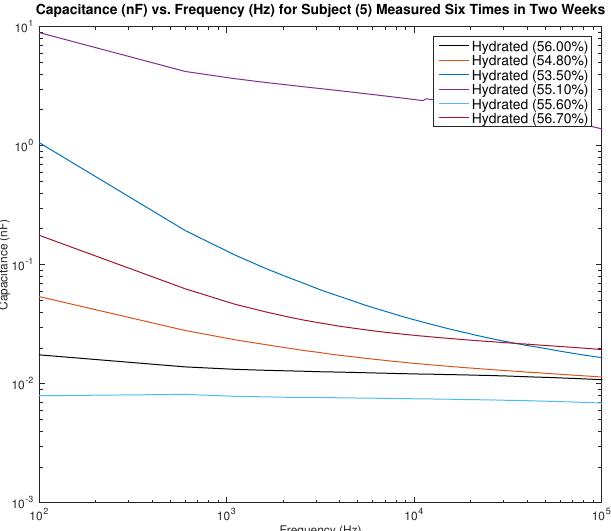
Figure 15. Testing results—capacitance (nF) vs. frequency (Hz) for subject 5 measured six times in two weeks on the left arm.